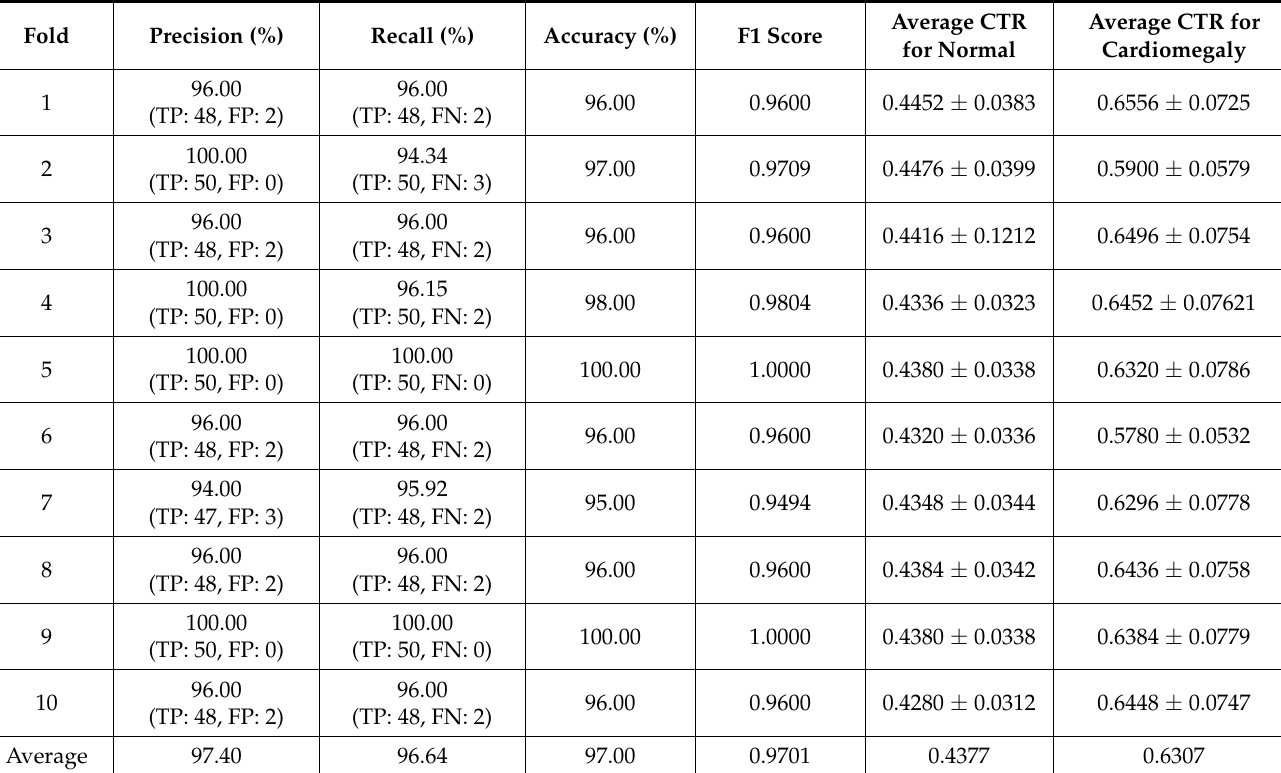
Table 2. Experimental results of 10-fold cross validation for the proposed multilayer